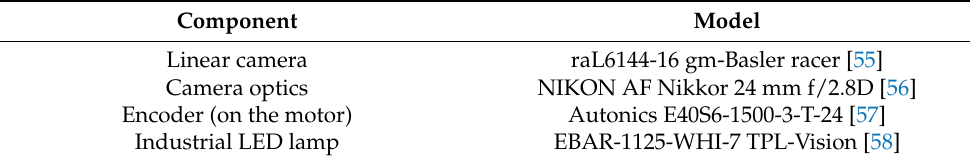
Figure 7. The image capturing set: ( a ) principle scheme, ( b ) laboratory setup. Linear camera pointing into the same line (area) as an industrial LED light source. The camera is triggered by an encoder on the motor. Table 1. Capturing set